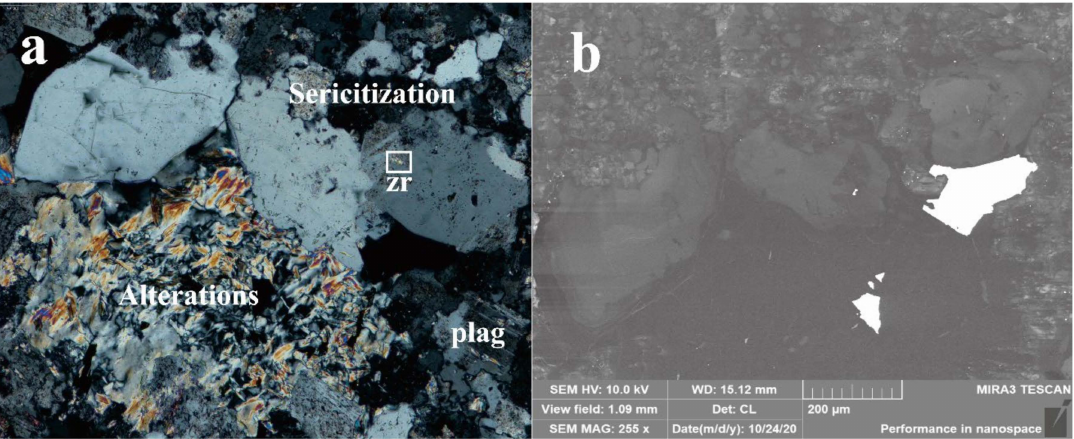
Figure 13. Sample H13-5 of orthophyre taken from Huangshaping deposit, southern China. ( a ) Sericitization and alteration with zircon inclusion in magmatic quartz phenocrysts and plagio- clase in surroundings. ( b ) CL image showing the internal texture. Abbreviation: plag—plagioclase;